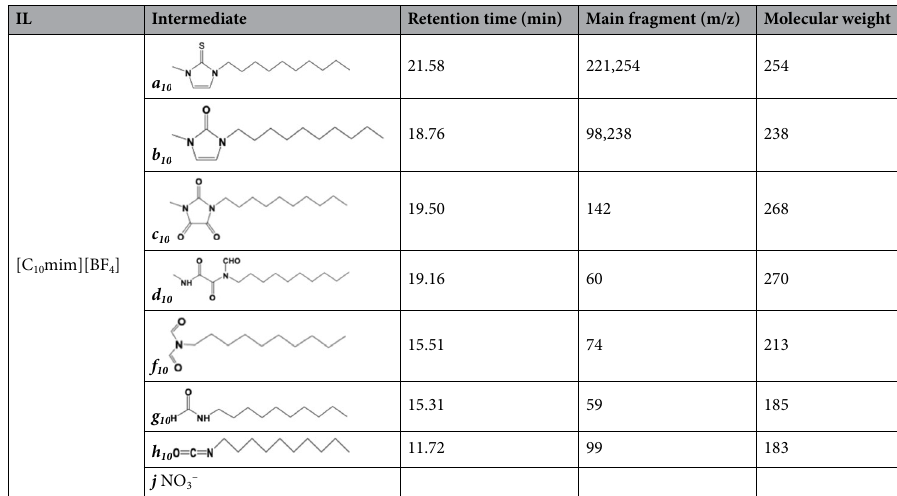
Table 2. Degradation intermediates of [C n mim][BF 4 ] detected by GC–MS and IC.